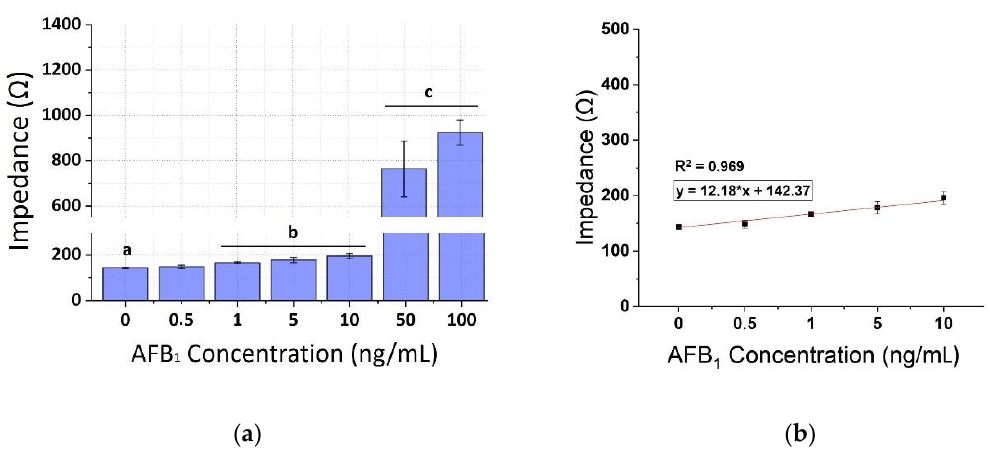
Figure 6. ( a ) Extracted results from the mean impedance magnitude values for different concentrations of AFB 1 standard solutions tested at three frequencies 1 KHz ± STD, Different letters (a, b, c, d, e) indicate statistically significant different values ( p < 0,05), ( b ) Linear fit curve of the values of the mean impedance magnitude for concentrations of AFB 1 standard (0−10 ng/mL) tested at 1 KHz.